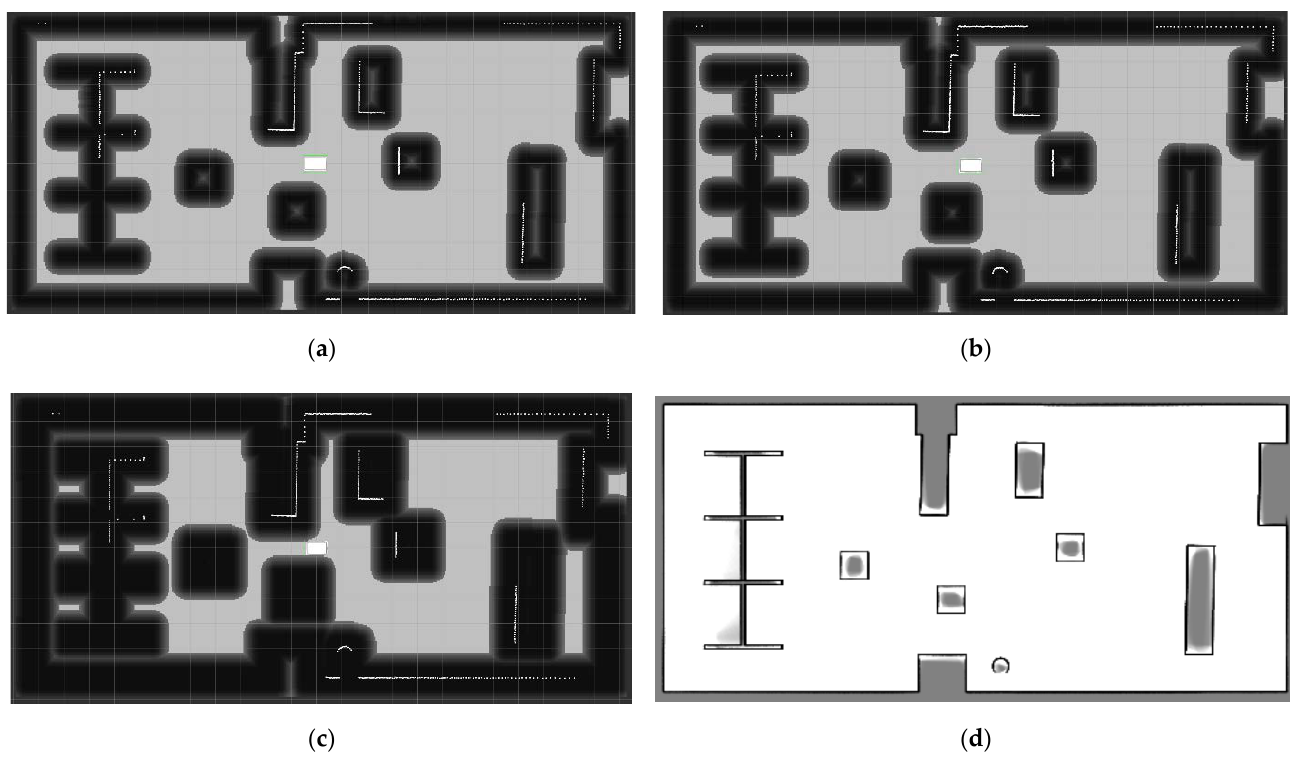
Figure 3. Grid map preprocessing. ( a ) h = 0; ( b ) h = 2; ( c ) h = 4; ( d ) original map.